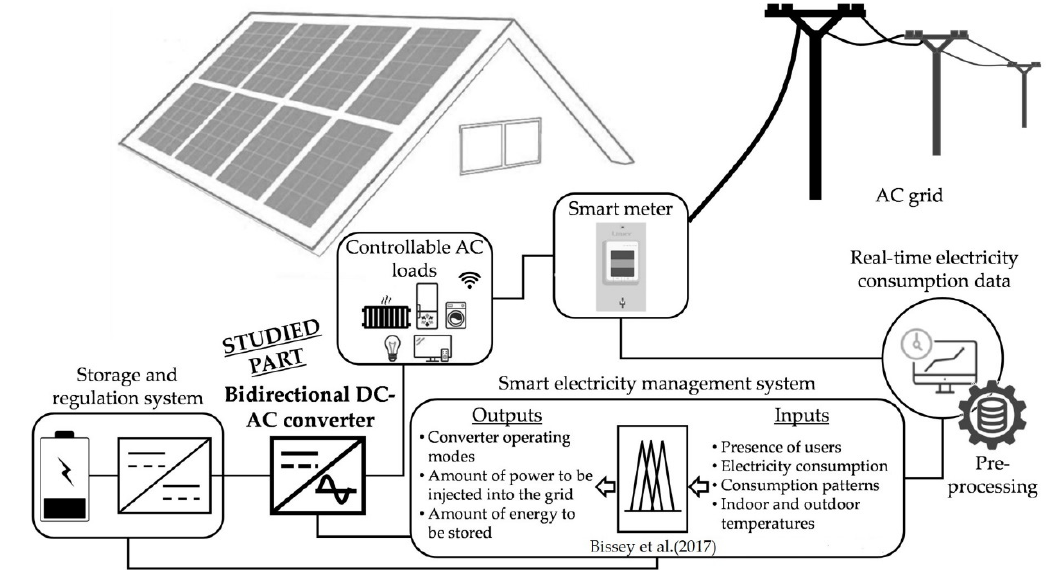
Figure 1. The principle of the smart HEMS implemented in this study [23].